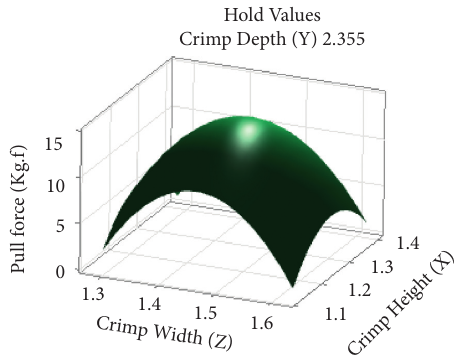
Figure 7: Surface plot of pull force versus crimp width ( Z ) and crimp height ( X